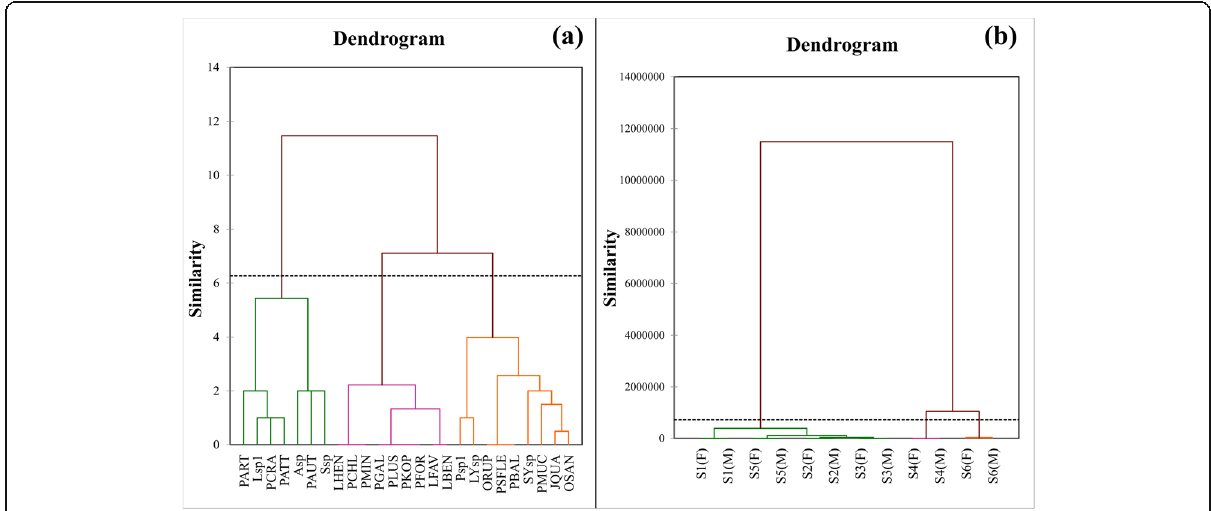
Fig. 6 Hierarchical clustering analysis using Ward ’ s method and Euclidean distance matrix. Clusters of accessions of cyanobacteria species groups ( a ) and sampling sites ( b ) were formed on the basis of soil physicochemical similarity; the graph representing classification is a dendrogram of similitude with standardized Euclidean distances representing the closest accessions in homogeneous